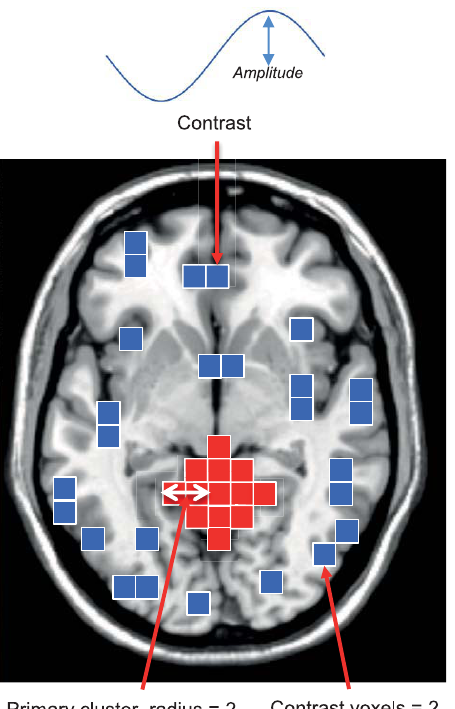
Figure 4. A figure displaying contrast properties which were altered during the simulation. ROC curves were calculated as the contrast parameters illustrated above were varied. The performance of methods was assessed as four parameters were varied: t – the initial threshold, CN – the contrast to noise, R – the radius of the primary cluster and CV – the number of contrast voxels outside of the primary cluster, as a multiple of the number of voxels in the primary cluster.